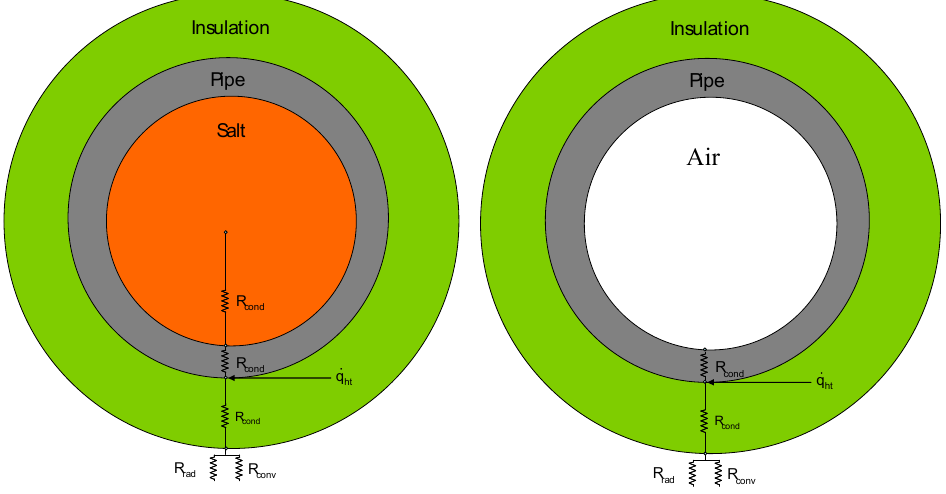
Figure 5. Thermal networks used for modelling melting ( left ) and preheating ( right ).